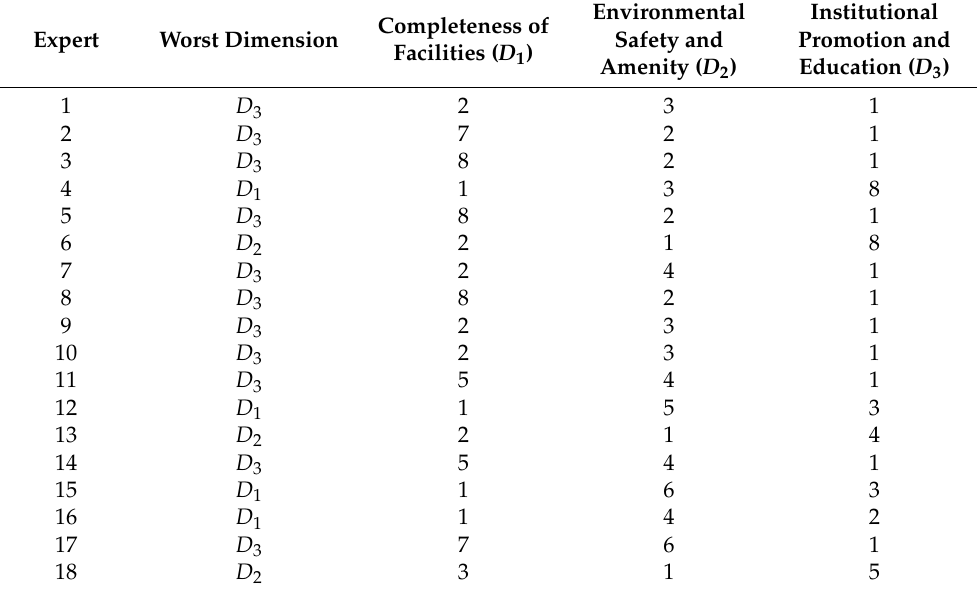
Table 5. OW vectors of the three dimensions.